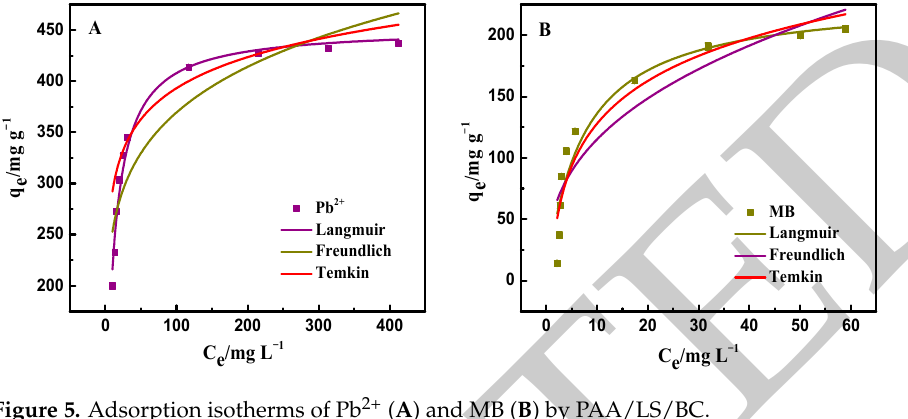
Figure 5. Adsorption isotherms of Pb 2+ ( A ) and MB ( B ) by PAA/LS/BC.